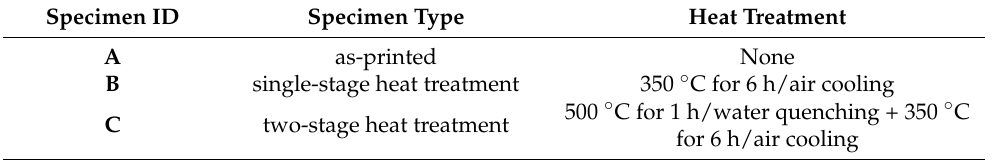
Table 3. Heat treatment parameter of SLM Al–Mg–Sc–Zr alloys .